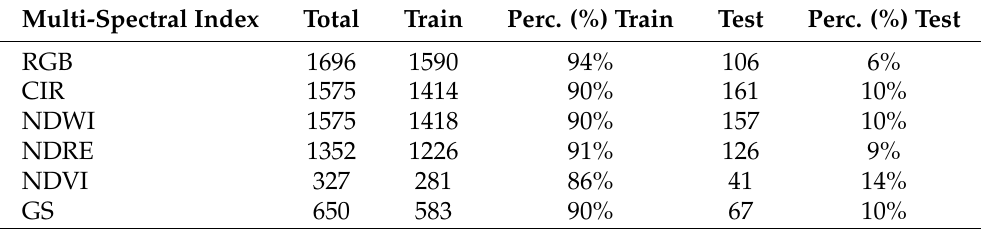
Table 1. Number of images per multi-spectral index. First dataset used for training. Total: total number of images; Train: total number of images used in training; Test: total number of images used for testing. Approximately 10% of Total was used for testing.